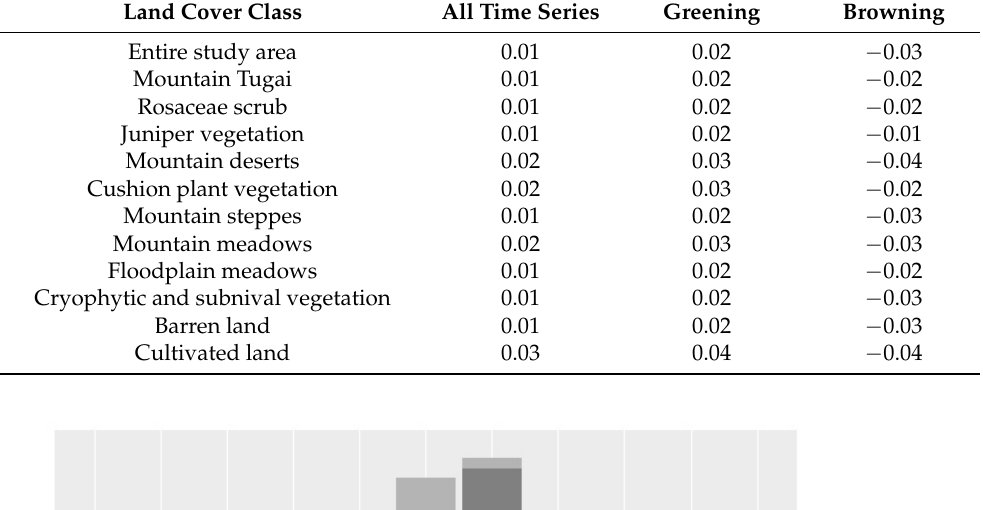
Table 3. Median of change according to land cover class and trend direction.